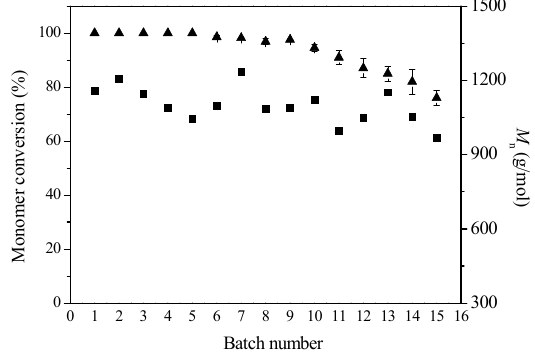
Figure 5. Monomer conversion and M n values for a series of consecutive batch reactions. Reactions were conducted at 80 °C for 72 h, using 80 mg immobilized enzyme EC-EP-AFEST, 200 μ L ε -caprolactone and 600 μ L toluene.